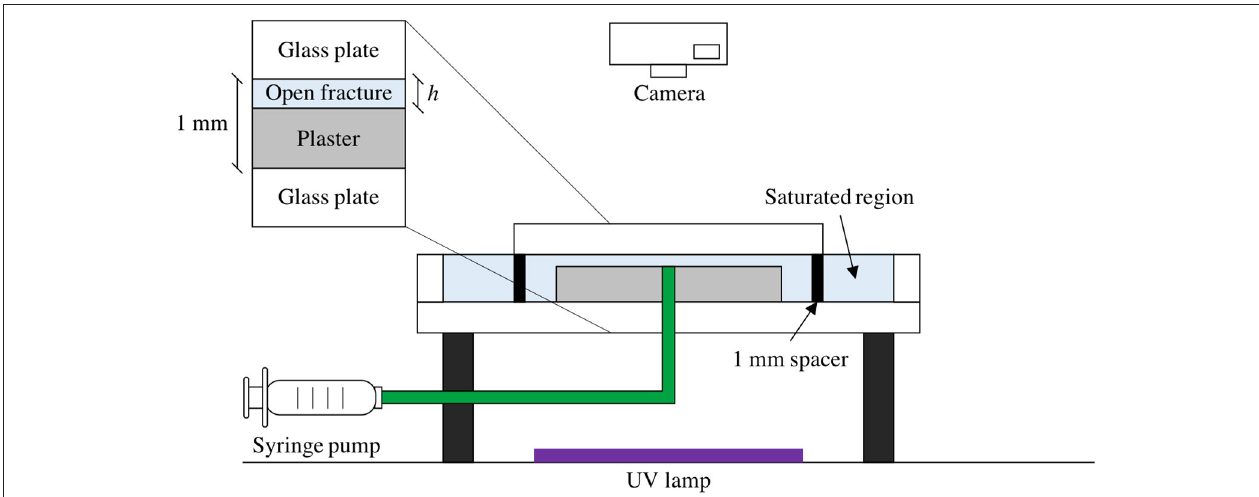
FIGURE 1 | Schematic diagram of experimental setup. A circular Hele Shaw cell (spacing 1 mm) contains a saturated plaster plate with a small gap ( h above the plaster. A tracer fluid is injected by a syringe pump into the center of the Hele Shaw cell, where it flows radially outwards. The model is illuminated from below by an ultraviolet light source. The plaster plate has a fixed dissolution pattern around the injection point, formed by distilled water injection before the tracer injection